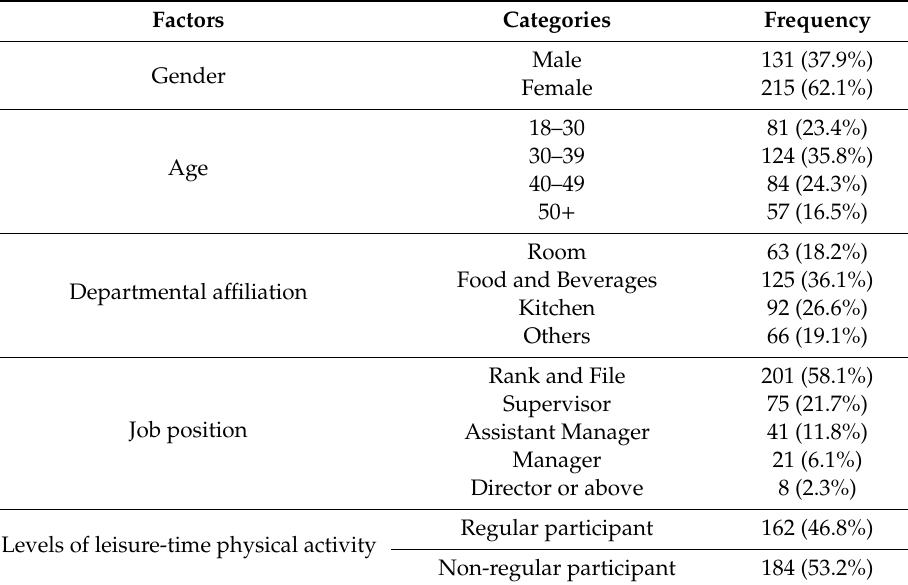
Table 1. Demographics of participants.